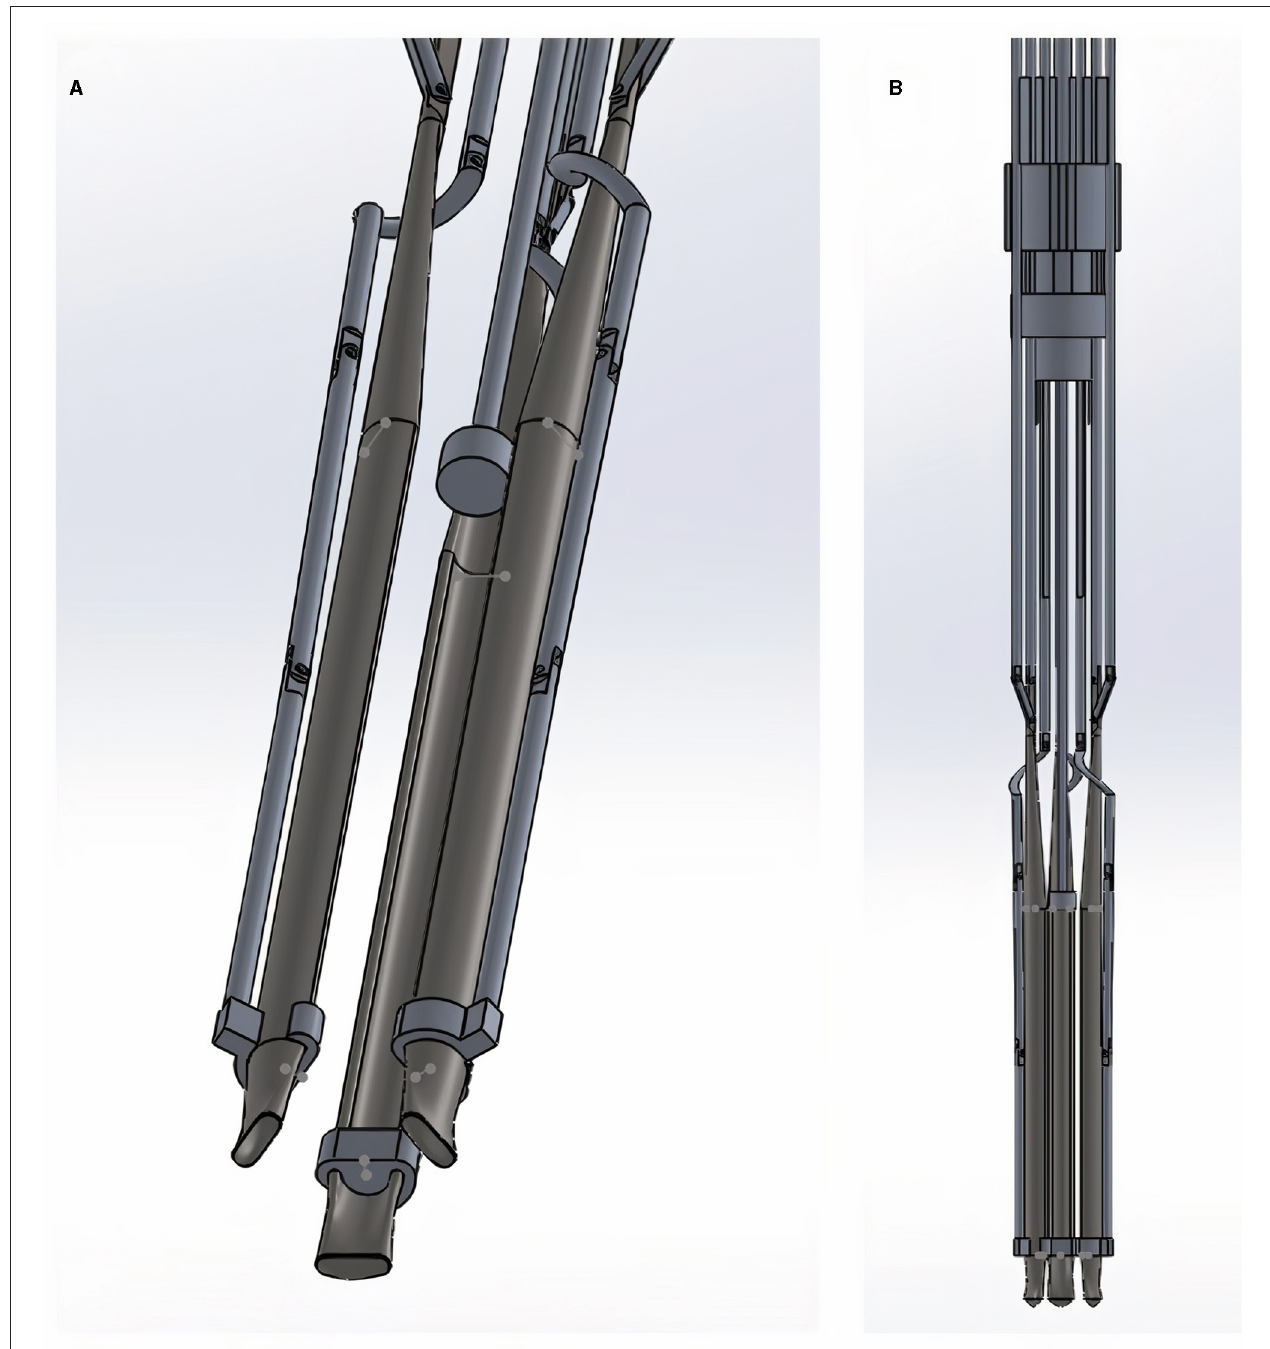
FIGURE 2 | (A,B) Close-up angled view (A) and complete lateral view (B) of the distal end of the instrument (the patient end where the patch would be enclosed). Movements of this compartment are controlled at the other (operator’s) end of the instrument by the connected Grips shown in Figure 1 .